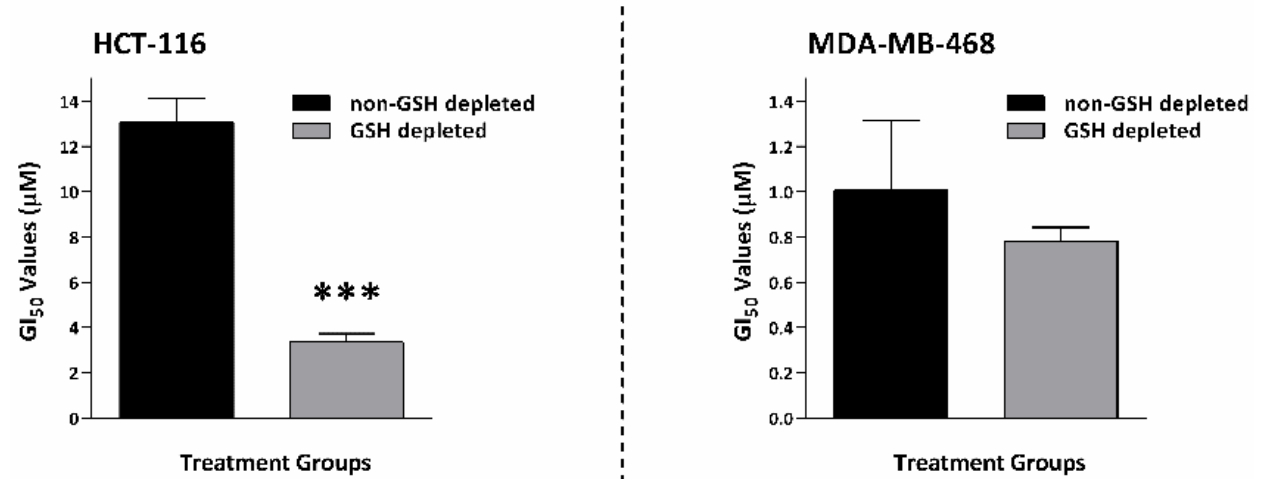
Figure 10. Mean ± SD bars show the effect of GSH depletion on TQ GI 50 in MDA-MB-468 and HCT-116. GSH depletion significantly enhanced HCT-116 sensitivity to TQ. Asterisks indicate statistically significant ( p ≤ 0.001) change compared to non-GSH depleted HCT-116. MDA-MB-468 showed slightly decreased GI 50 , which was not significant. No. trials ≥ 3; n = 4 per independent experiment.